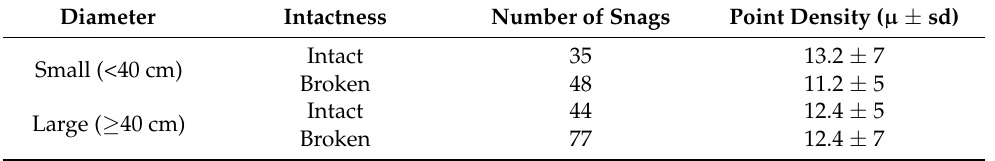
Figure 2. Sample lidar point clouds by snag class. Representative ALS point clouds for each snag class are viewed from ground level as 2.5 m radius circular clips around snag center coordinates (marked by white triangles). Lidar returns are colored by height above ground. The dashed hori- zontal line represents the height at which snag diameter was measured (1.37 m above ground). The four snag classes shown illustrate the differences across diameter (small (<40 cm DBH) vs. large ( ≥40 cm DBH )) and intactness (intact vs. broken top): ( a ) a representative “small intact” (SI) snag; ( b ) a representative “small broken” (SB) snag; ( c ) a representative “large intact” (LI) snag; ( d ) a representative “large broken” (LB) snag. Table 3. Summary statistics by snag class across all snags (n = 198) measured in conifer forests in Idaho, USA. A breakdown of airborne lidar point density (total returns/area) per snag point cloud is included, with mean (µ) and standard deviation (sd) for each snag class. Snags split by study site are not shown, but overall there were more snags at CdA (n = 141) than StJ (n = 63), driven primarily by a greater number of broken top snags in both size classes.